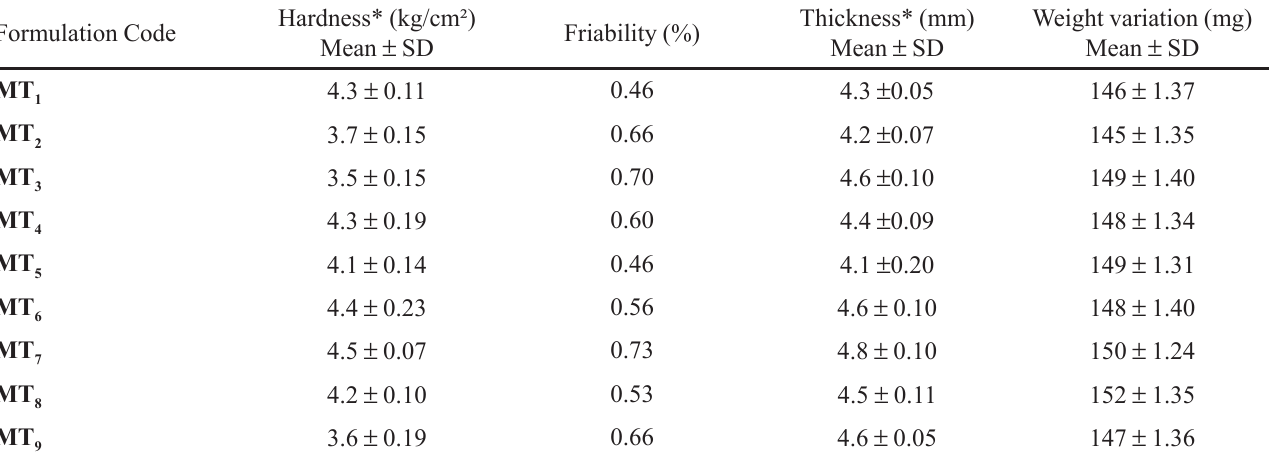
TABLE V - Post-compressional parameters for direct compression method Formulation